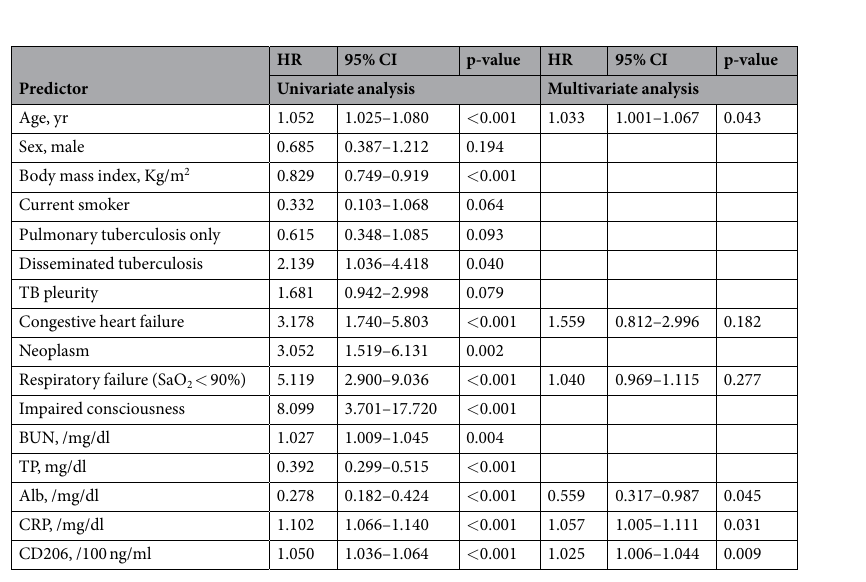
Table 2. Prediction of mortality with pulmonary tuberculous patients: univariate and multivariate analyses. HR; hazard ratio, CI; confidence interval, BUN; blood urea nitrogen, TP, total protein, Alb; alubumin, CRP; C-reactive protein, SAA, serum amyloid